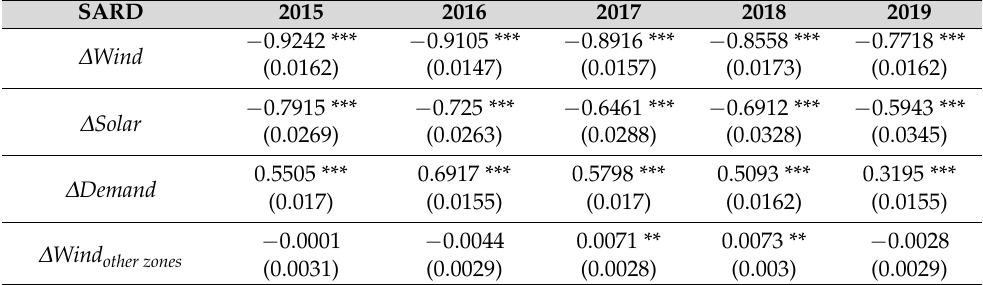
Table A10. OLS estimation of hourly changes in net input flow of SARD; results of Equation